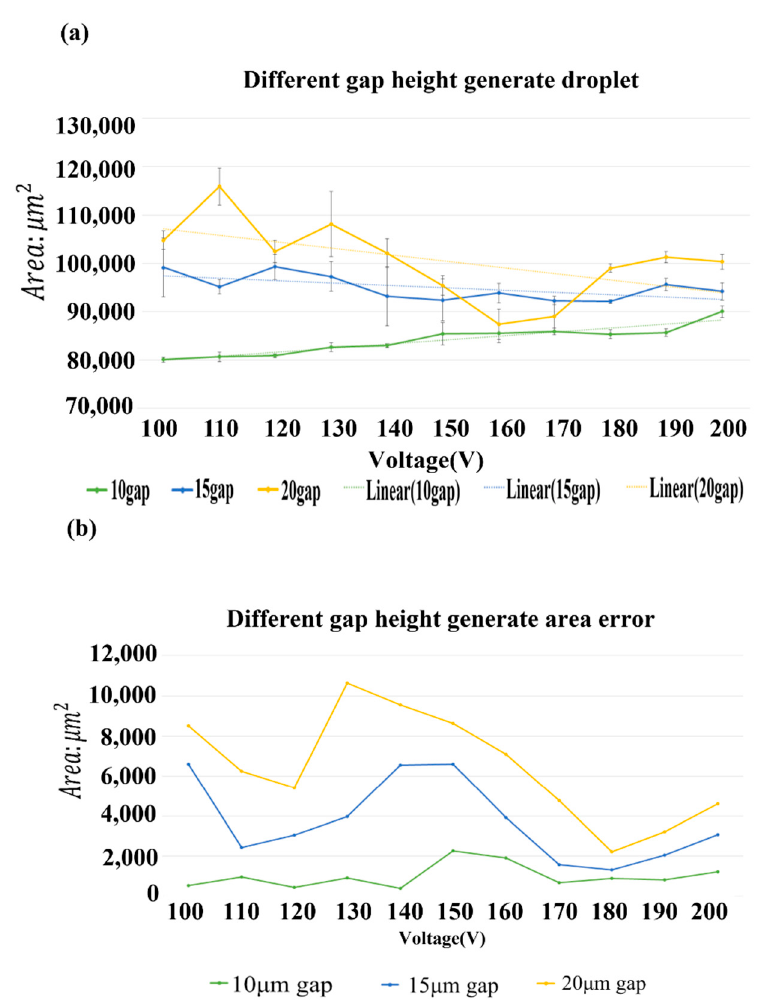
Figure 7. ( a ) Variation of droplet size with 10 µ m, 15 µ m and 20 µ m gap height and voltage variety; ( b ) error of area measurement with 10 µ m, 15 µ m and 20 µ m gap height and voltage variety.